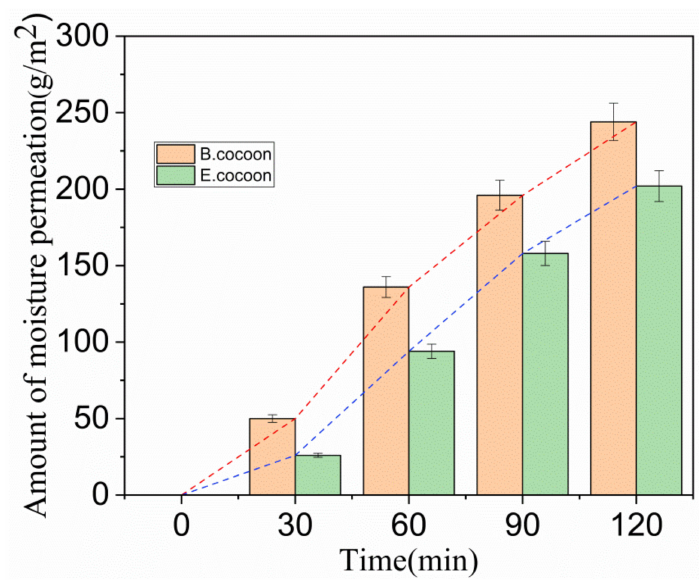
Figure 8. Relationship between amount of moisture permeability and